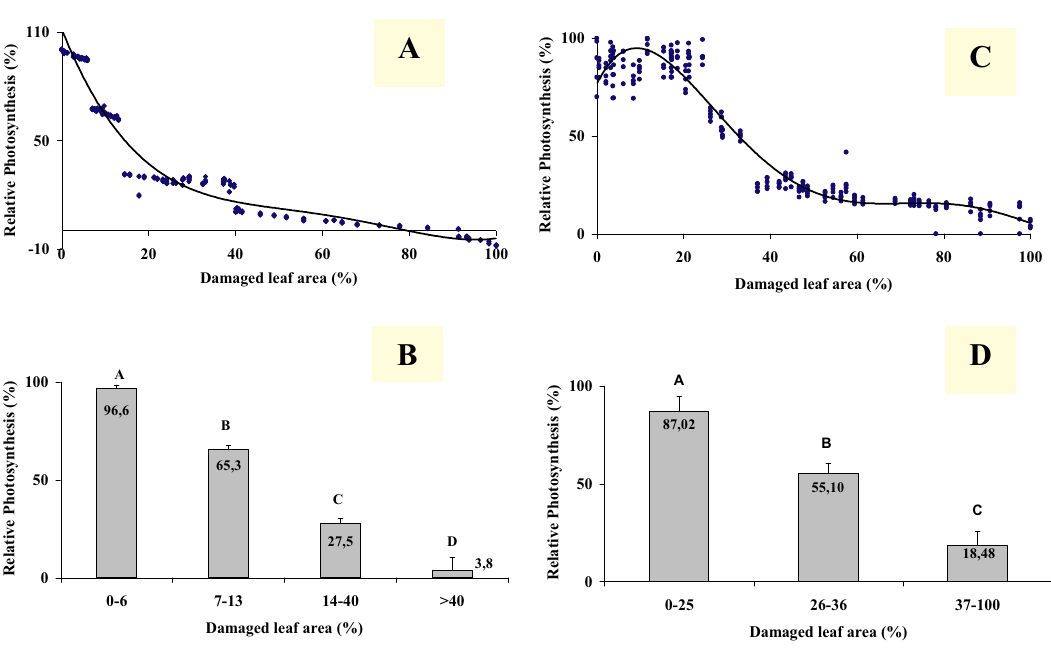
Fig. 3– Effectofleafareadamaged(0to100%)by O.praelonga and L.coffeella onrelativephotosynthesis(%). Effectof O.praelonga infestation intensity at four relative photosynthesis intervals on lime leaves (A and B) and of L. coffeella on Obatã coffee leaves, at three intervals (C and D). Treatments followed by the same letter do not differ by Tukey test, at 5%